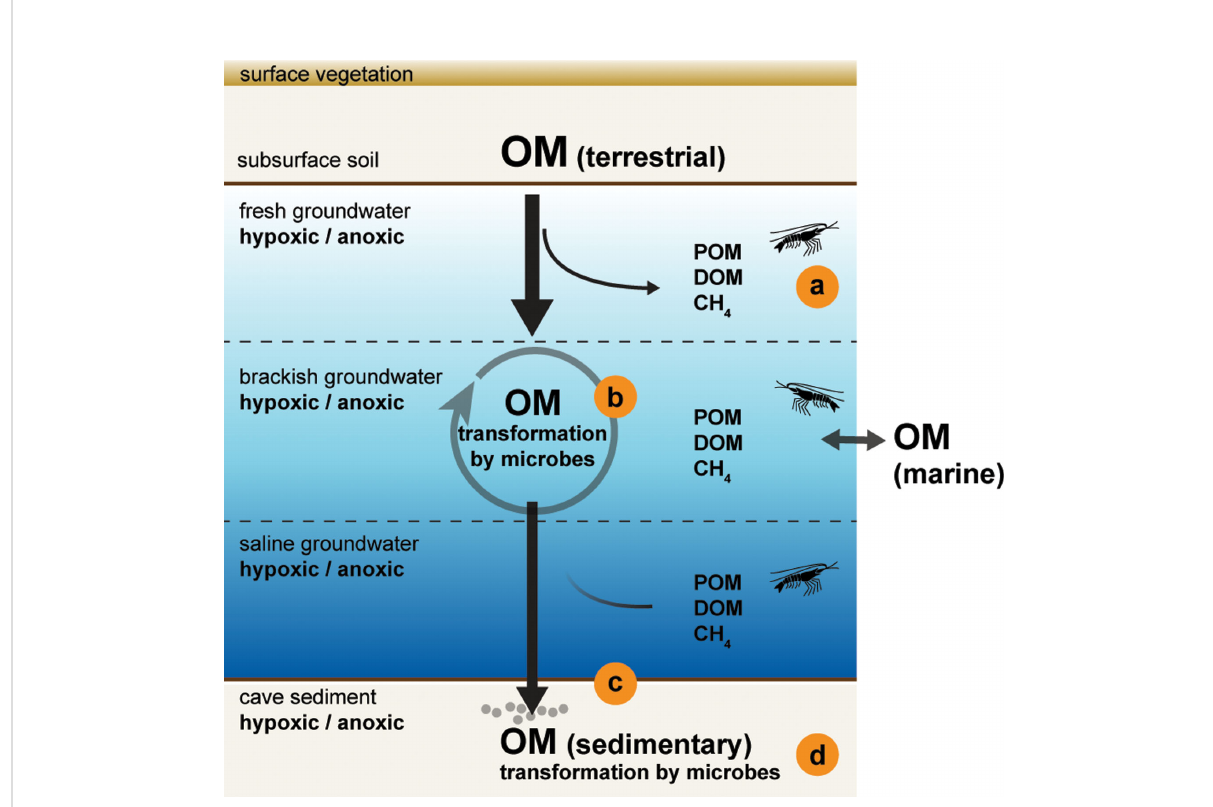
FIGURE 1 Conceptual model of organic matter (OM) inputs and transformation in a coastal cave environment fl ooded by fresh and saline groundwaters, a typical anchialine ecosystem. The inputs and consumption of OM affects the concentrations of dissolved oxygen, particulate organic matter (POM), dissolved organic matter (DOM), and methane (CH 4 ) in the water column. The salinity and chemical gradients create a set of habitats in this environment. Studies submitted to this Research Topic include investigations of (A) the physiological adaptations of cave-adapted crustaceans (Cha ́ vez-Sol ı ́ s et al., 2022), (B) microbial assemblages in the strati fi ed water column (Elbourne et al., 2022), and the effects of sedimentary OM deposition over time on (C) meiofaunal assemblages (Cresswell and van Hengstum, 2022) and (D) microbial communities (Risley et al.,